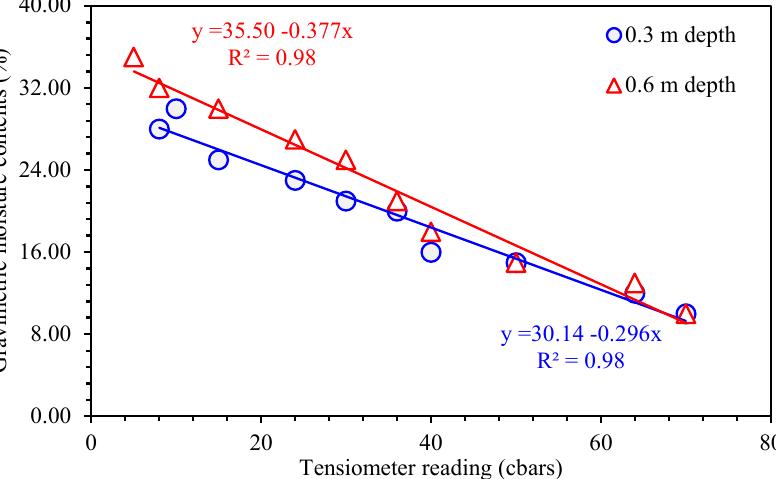
Figure 5. Calibration curves of tensiometer sensors with gravimetric moisture content at 0.3 and 0.6 m depths.